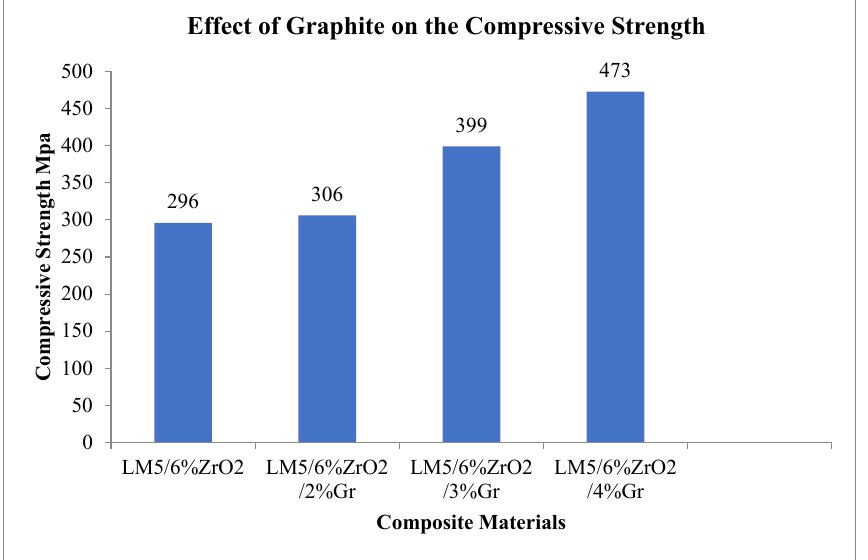
Figure 18. Effect of graphite on the compressive strength of composites.